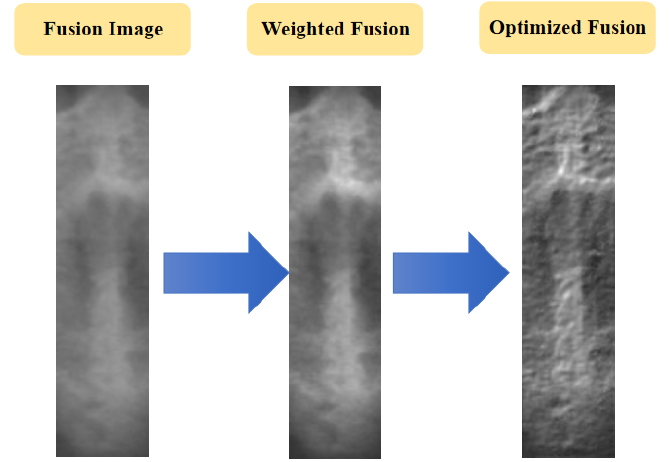
Figure 8. Examples of image fusion optimization process.